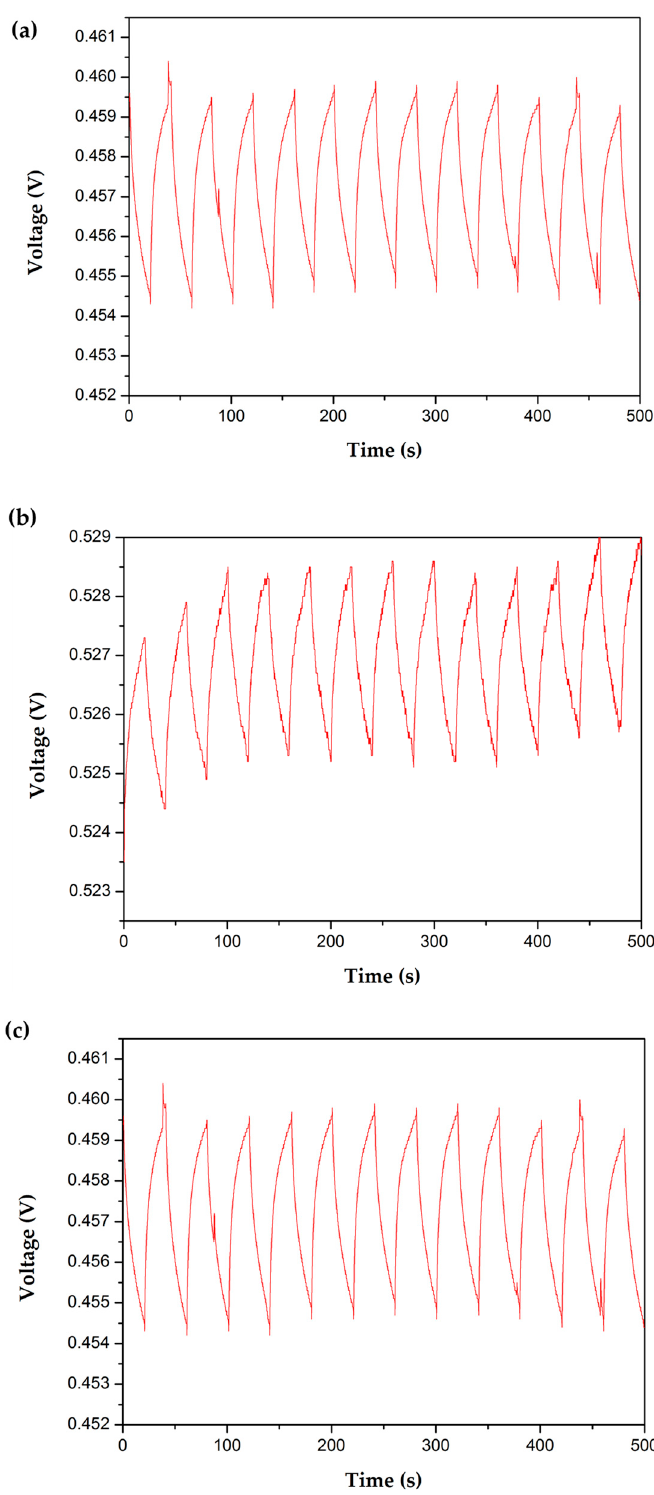
Figure A11. A typical photovoltaic response for PA–a ( a ); PA–b ( b ); and PA–d ( c ) film immobilized on ITO glass upon exposure to light with switching at room temperature.